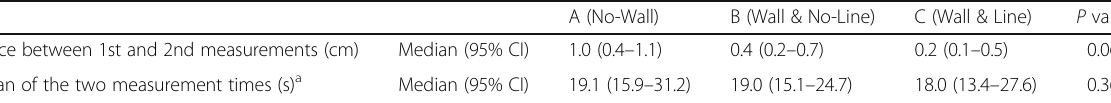
Table 1 Comparison of three measurement